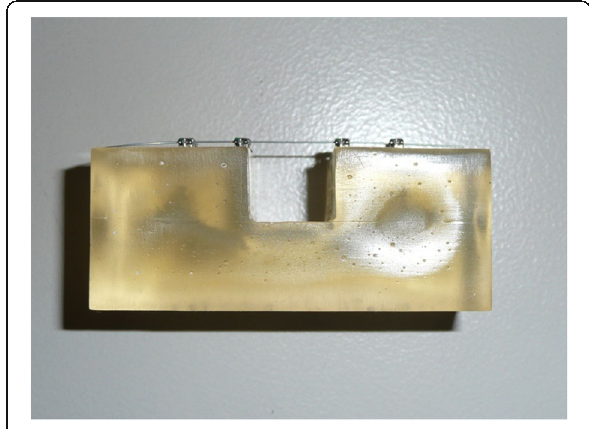
Fig. 3 Mounted archwire on the acrylic resin